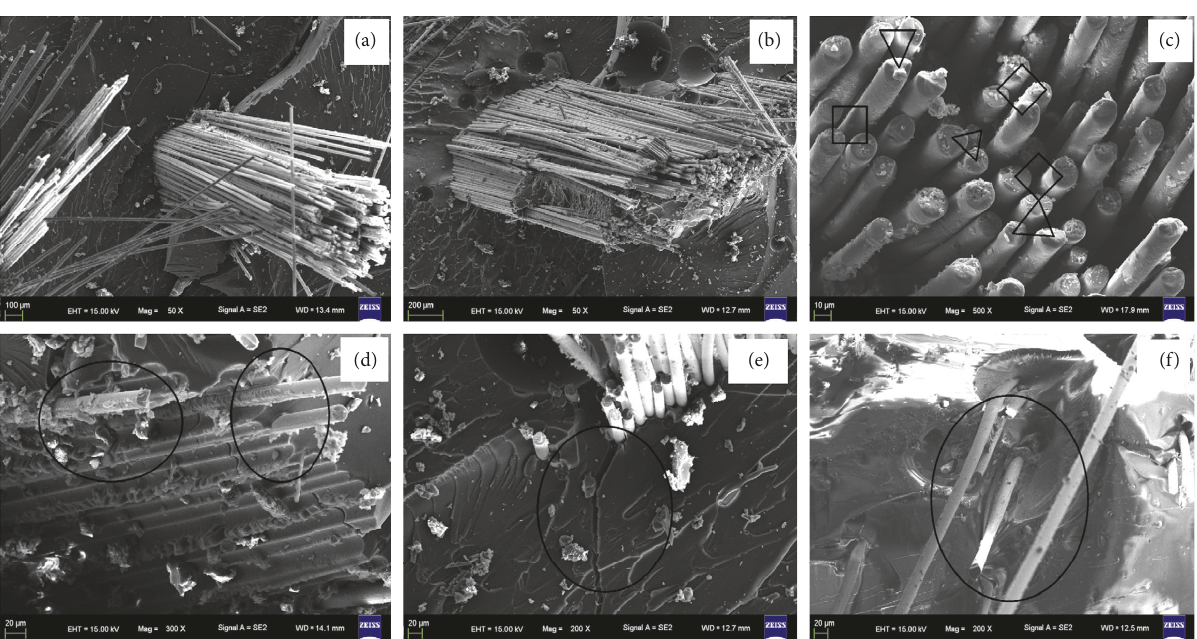
Figure 5: E-sports scan results of the BF/EP composite material sample fracture surface.